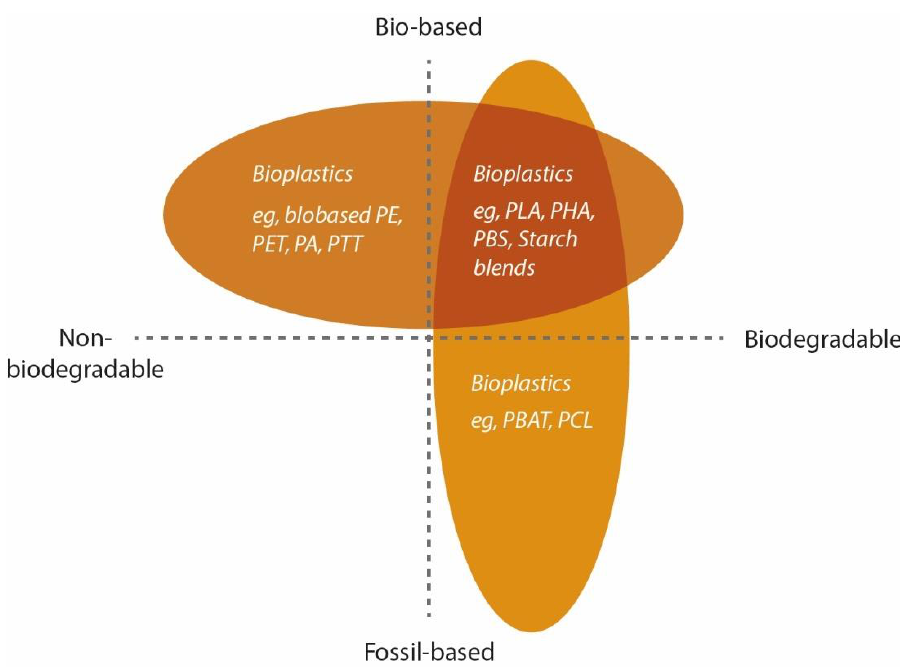
Figure 2. Classification of bioplastics according to The European Bioplastics Organization. Adapted from European Bioplastics, “What are bioplastics?” . https://docs.european-bioplastics.org/publica- tions/fs/EuBP_FS_What_are_bioplastics.pdf (accessed 29/12/2022) [13].